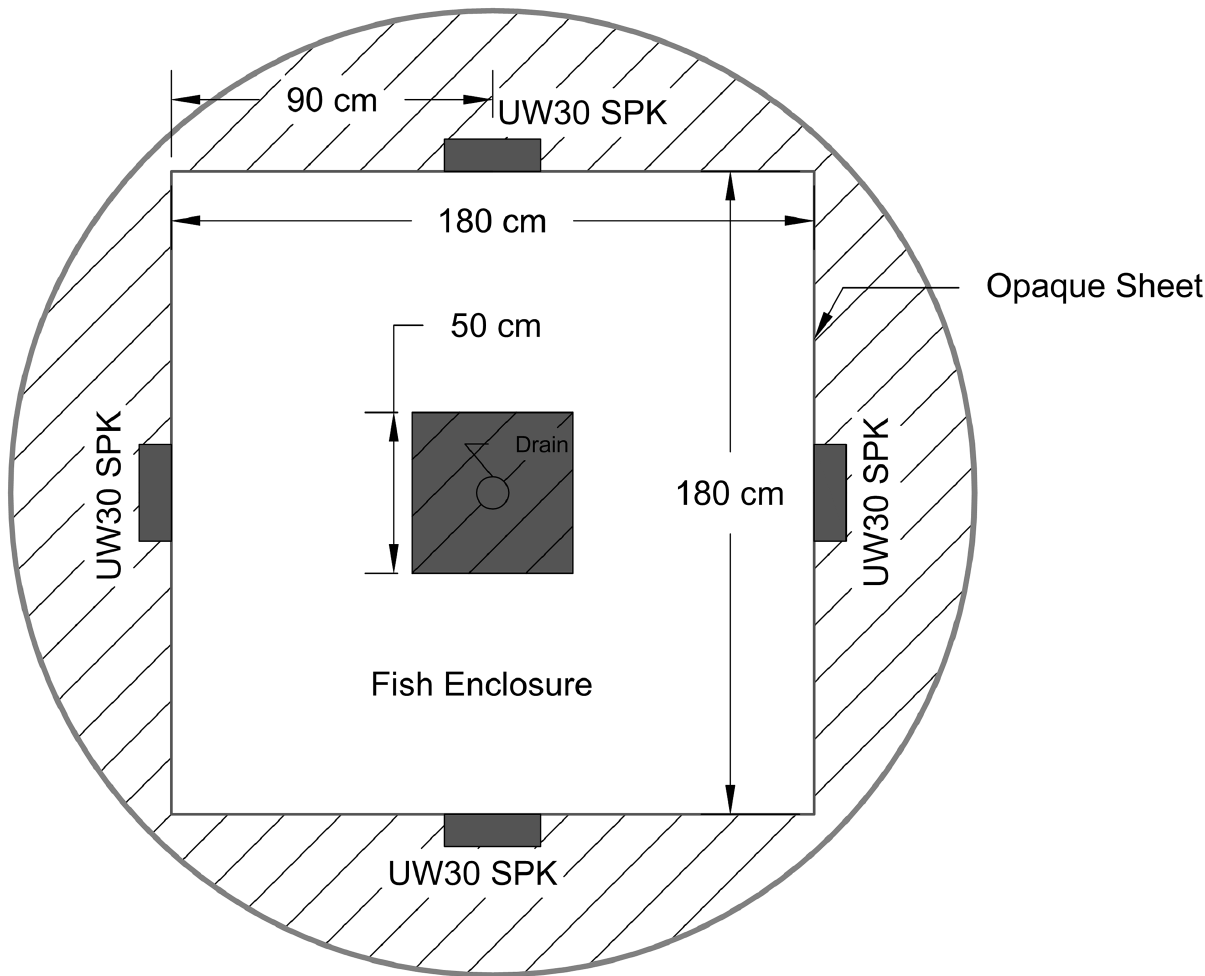
Fig 1. Schematic of the experimental tank showing the locations of the speakers,plastic enclosed testing arena, and drain cover box. The outsidediameterof the tank was 3 m and the water depth was 30 cm. The tank was darkenedby a black plastic tarp which covered it and illuminatedby infrared